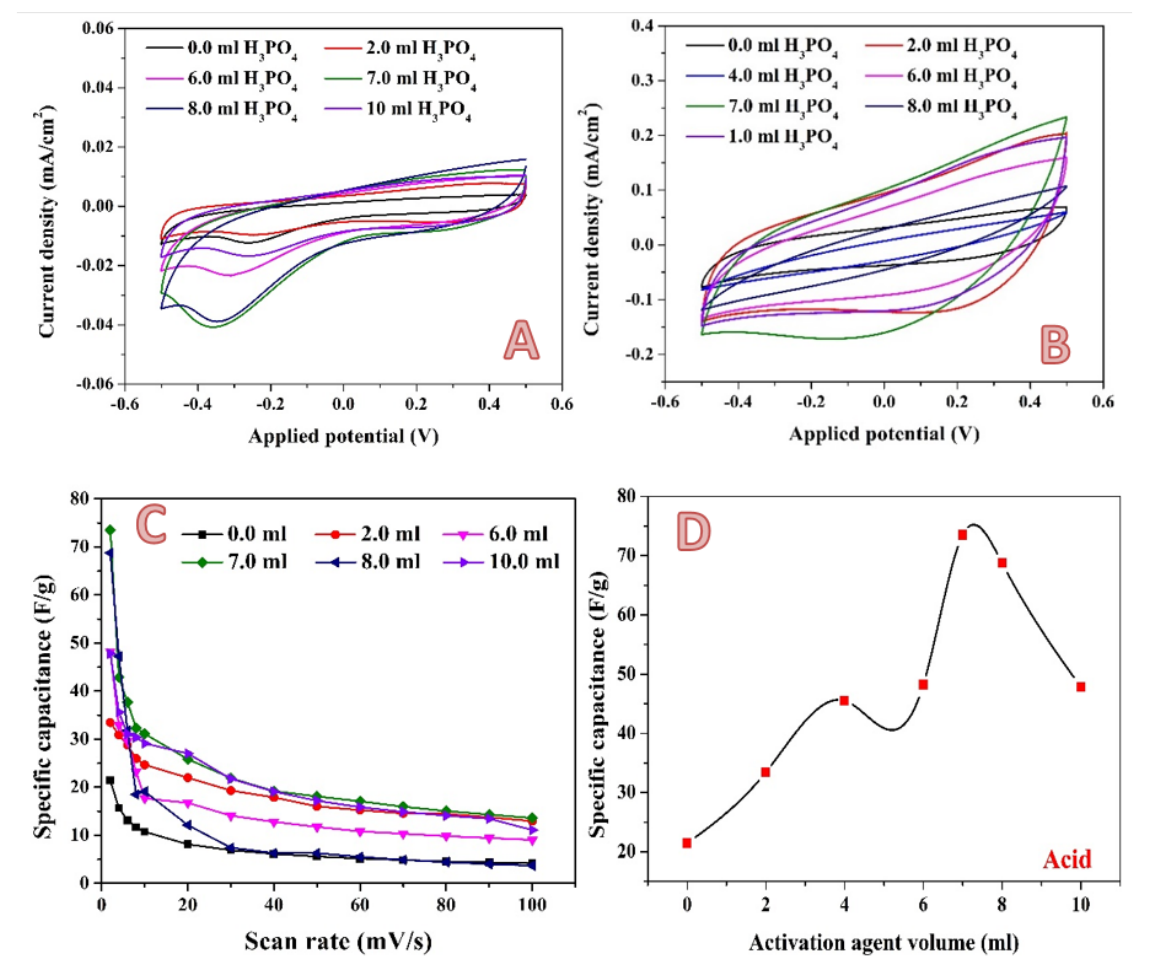
Figure 8. Cyclic voltammograms in the presence of 0.1 M H 2 SO 4 electrolyte at a scan rate of 2 mV; ( A ) and 100 mV/s; ( B ) for the 0.3 g activated carbon obtained from rice husk using different volumes of phosphoric acid. Influence of the scan rate on the specific capacitance; ( C ) and effect of the phosphoric acid volume on the specific capacitance (at 2 mV/s); ( D ).